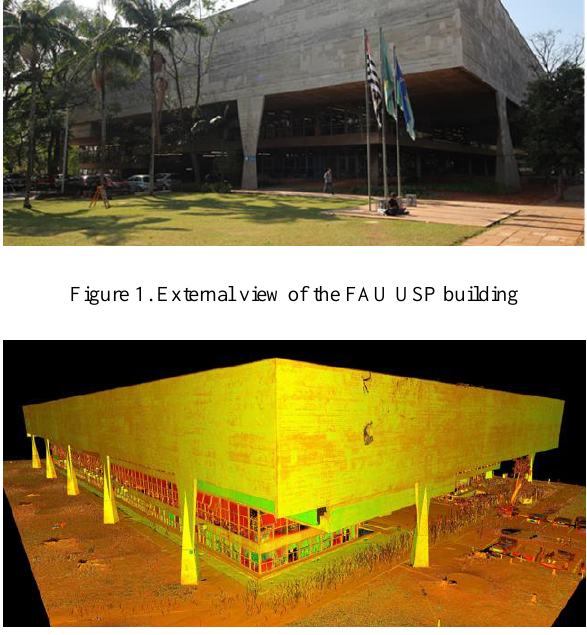
Figure 2. The 3D model of the building in point cloud